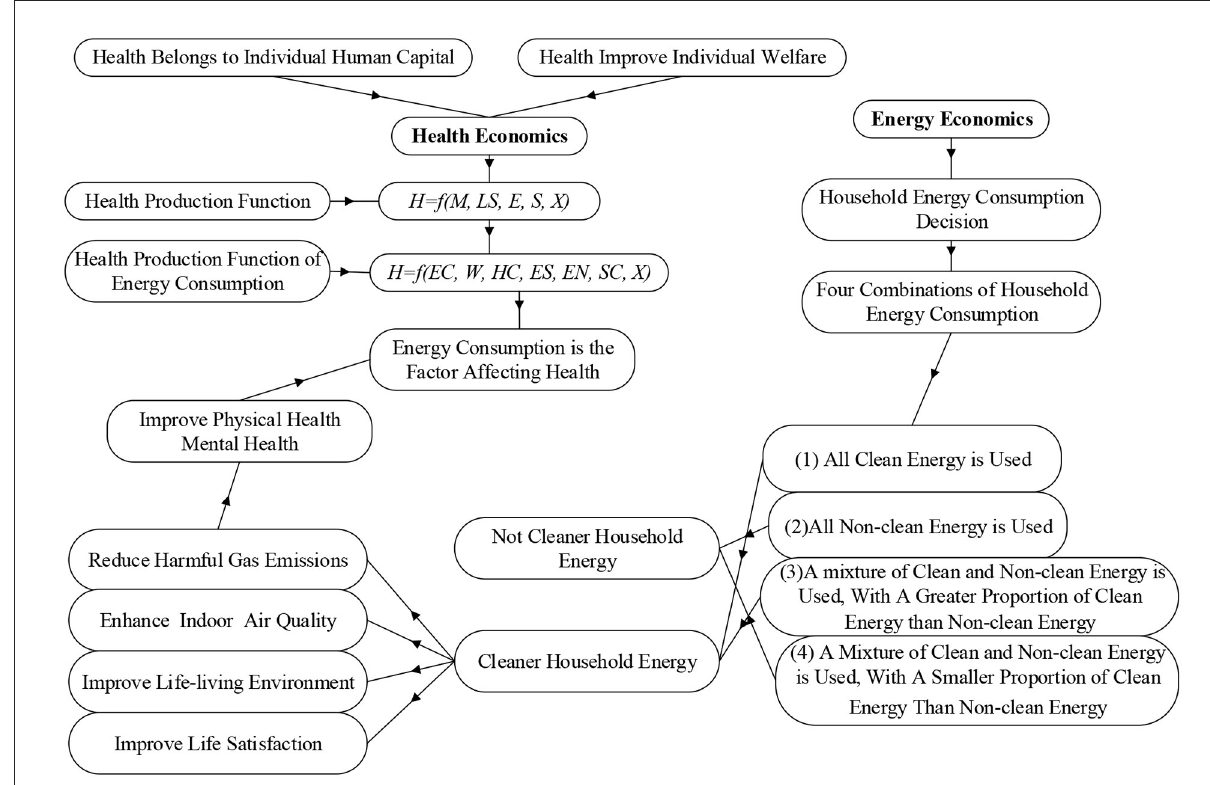
FIGURE2 The theoretical mechanism of household clean energy consumption affecting health. Source: The author draws according to the